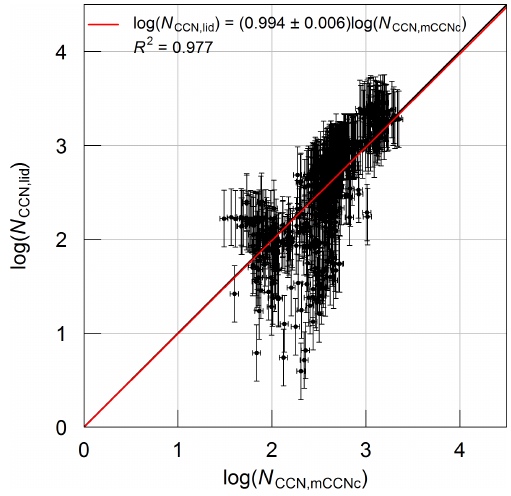
Figure 12. Correlation of the logarithmized (base 10) CCN-NC derived with the approach of Mamouri and Ansmann (2016) ( N CCN,lid ) and directly measured with the mCCNc on ACTOS ( N CCN,mCCNc ) for six profiles conducted during three flights (14a, 14b, and 27a). Each profile has its associated lidar profile. Red line represents the line of fit and the black line the 1 : 1 line. Error bars represent the uncertainty of the lidar-based approach of a factor of 2 and the 10% uncertainty of the mCCNc on